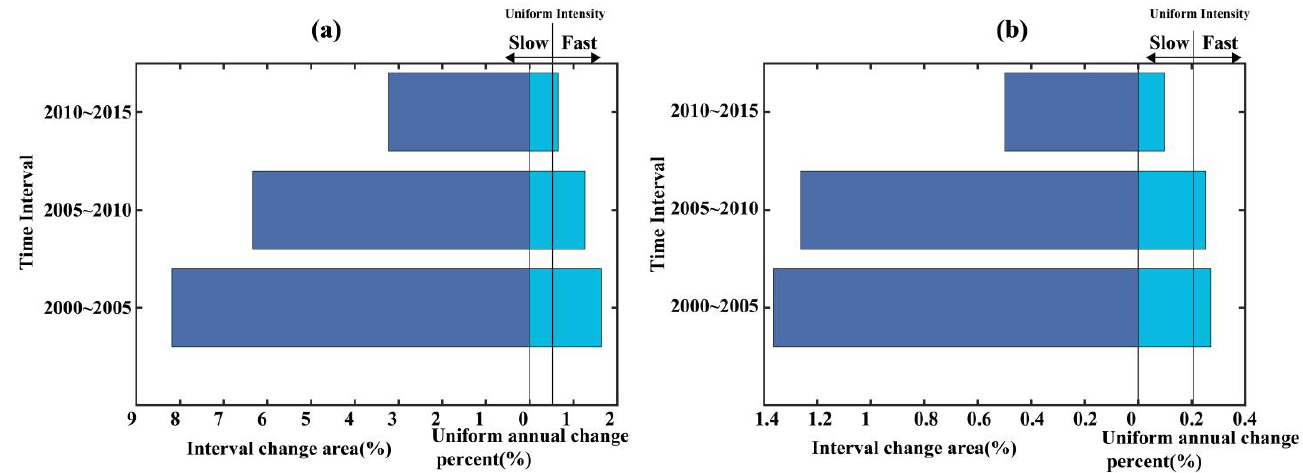
Figure 4. Changes in area and intensity of desertified lands in the interval level of the East Ujimqin Banner ( a ) and the three counties in Mongolia ( b ).